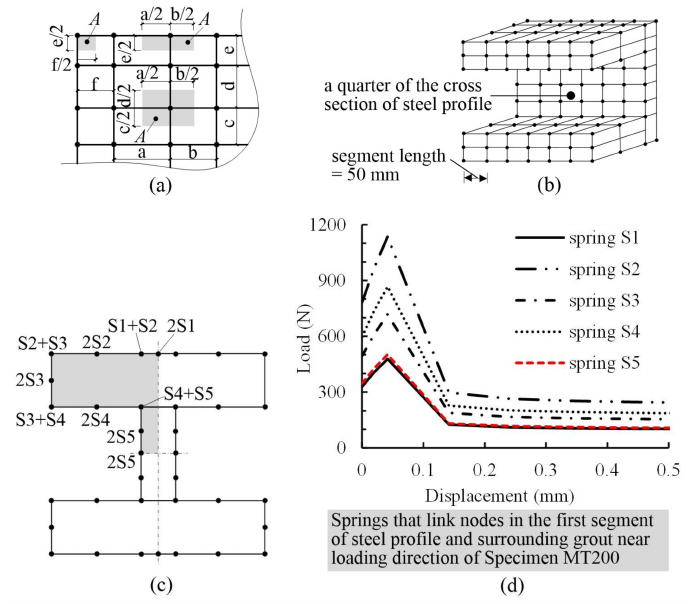
Figure 14. Implementation of bond stress-slip relationship for steel profile and grout in FEM models: ( a ) computation of A i ; ( b ) segments of steel profile along the loading direction; ( c ) springs Sl~S5; and ( d ) force-displacement relationship of springs